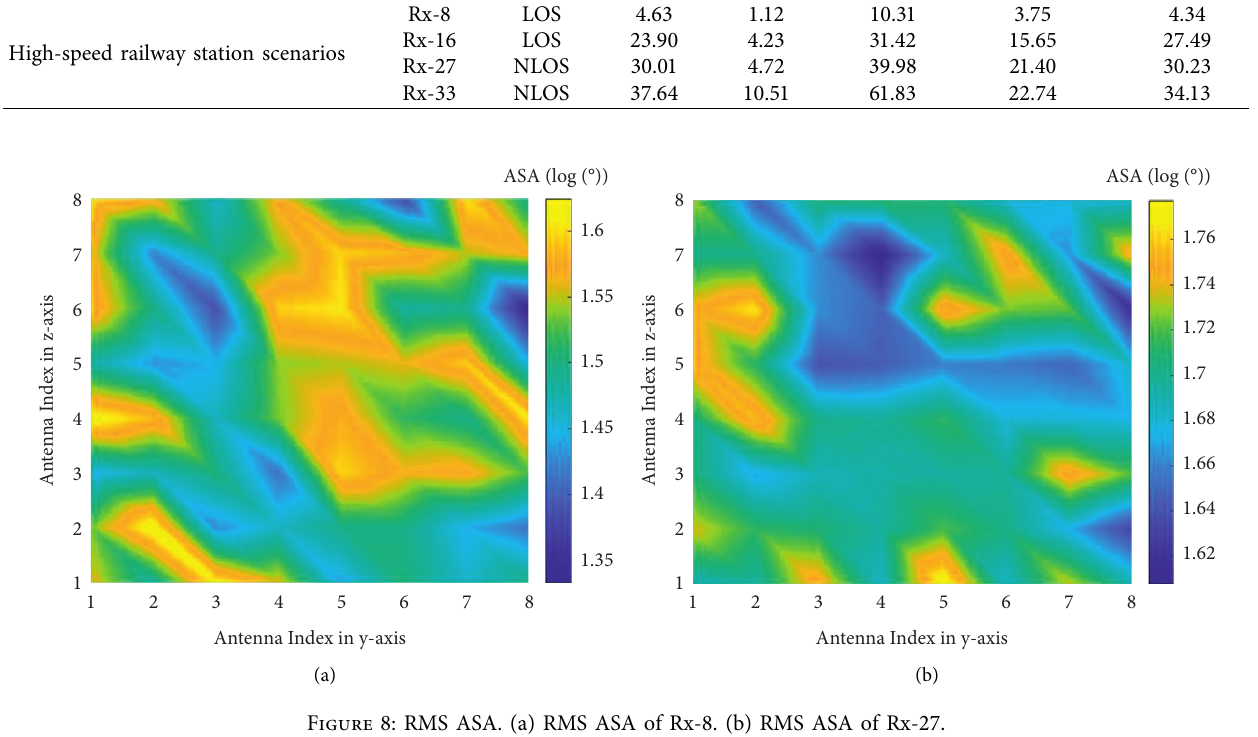
Figure 8: RMS ASA. (a) RMS ASA of Rx-8. (b) RMS ASA of